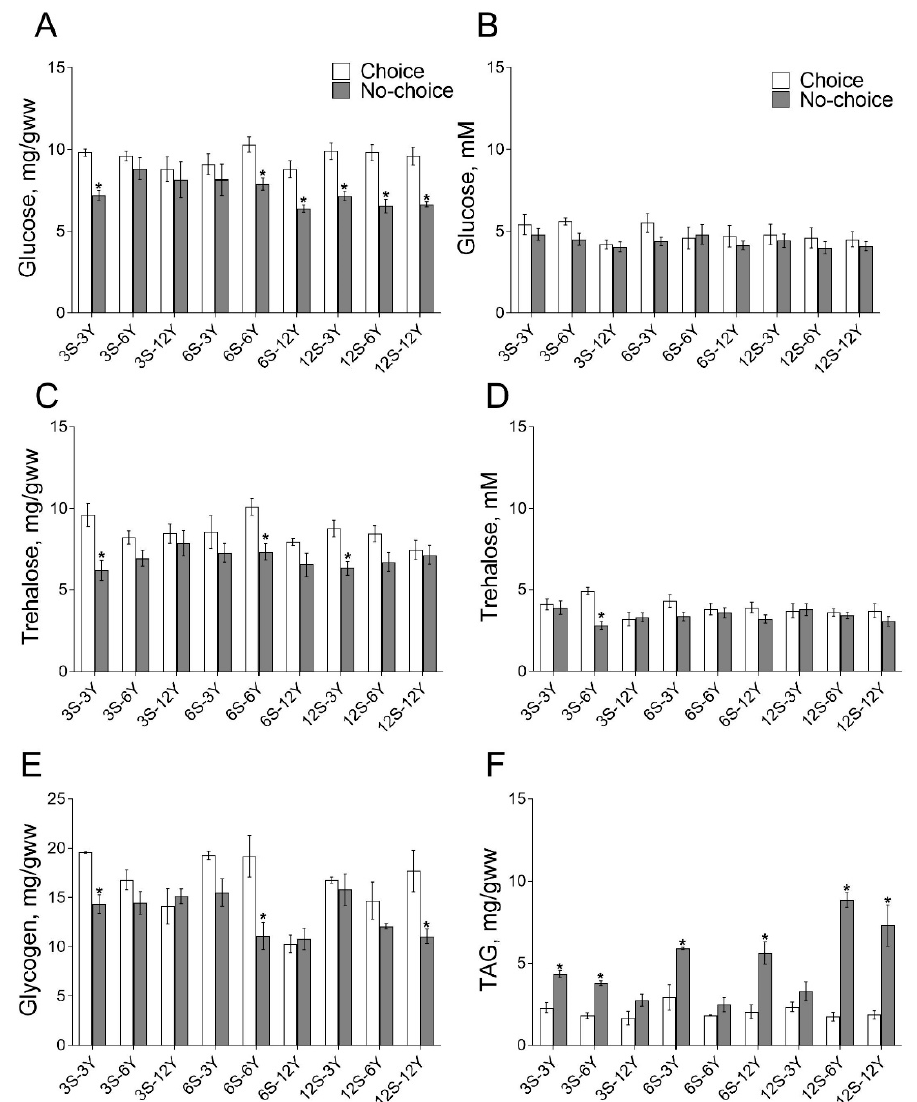
Figure 1. Effects of dietary choice on the levels of metabolites. Body glucose ( A ), hemolymph glucose ( B ), body trehalose ( C ), hemolymph trehalose ( D ), glycogen ( E ) and triglycerides ( F ) under choice and no-choice nutrition. S—sucrose percent in the medium; Y—yeast percent in the medium. Data are presented as mean ± S.E.M. for 4–5 independent replicates, values were considered significantly different if p < 0.05 and marked with *. The icons in the subfigures A also apply to C–F.